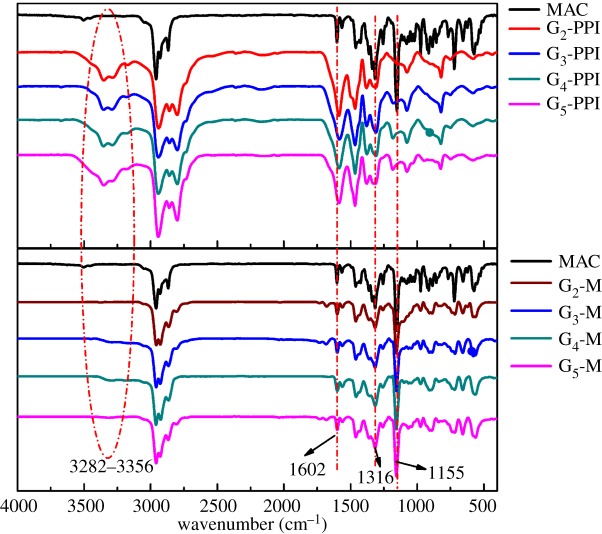
FTIR spectra of MAC, Gn-PPI and GnM (n = 2, 3, 4, 5).